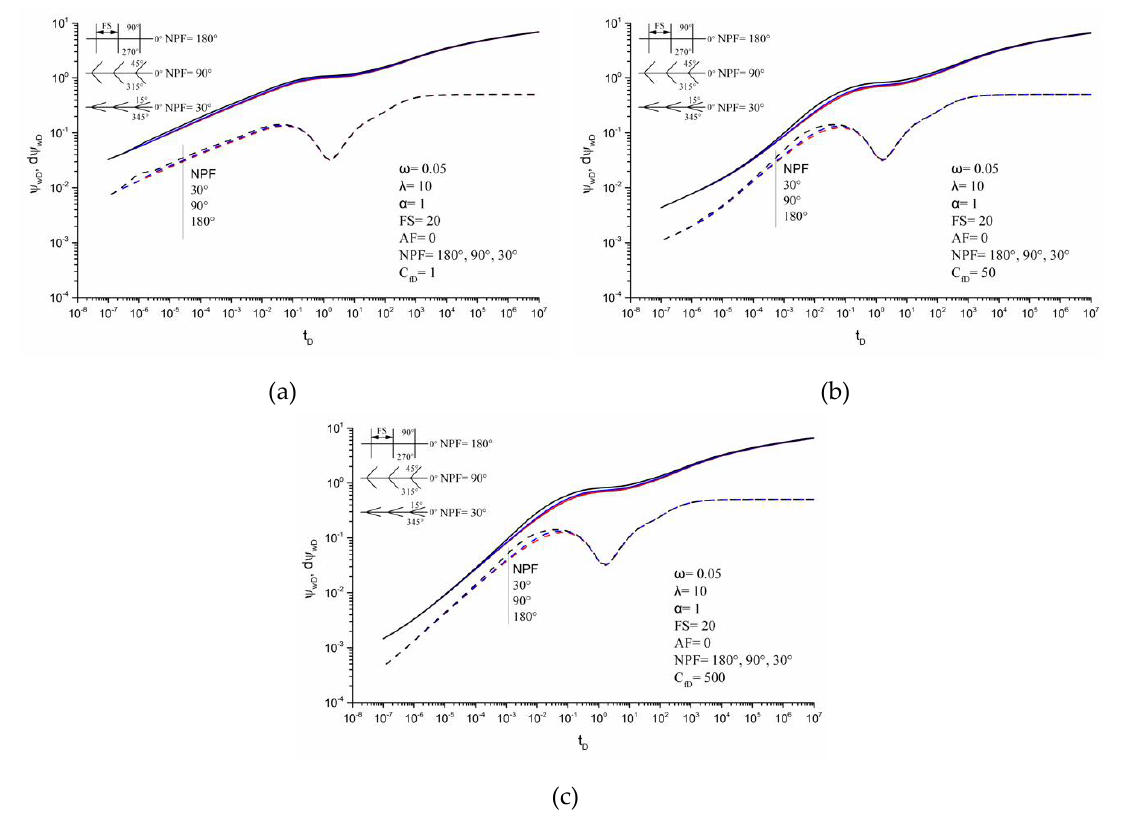
Figure 12. The typical pseudo-pressure curves of a multi-fractured horizontal well with different non-planar angle. ( a ) Low conductivity; ( b ) intermediate conductivity; ( c ) high conductivity.